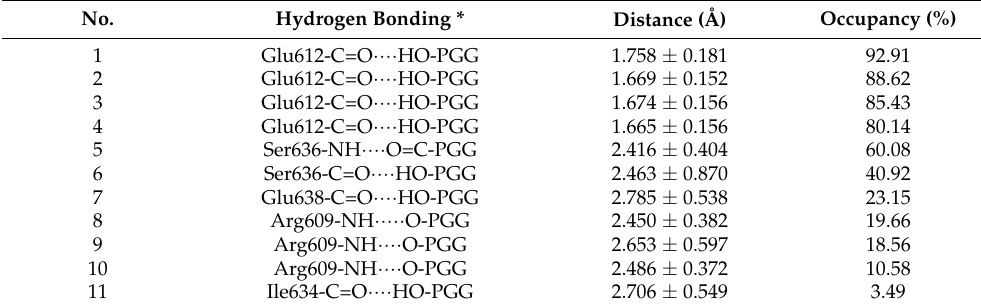
Table 2. Most contributed hydrogen bonding interactions between PGG and STAT3.